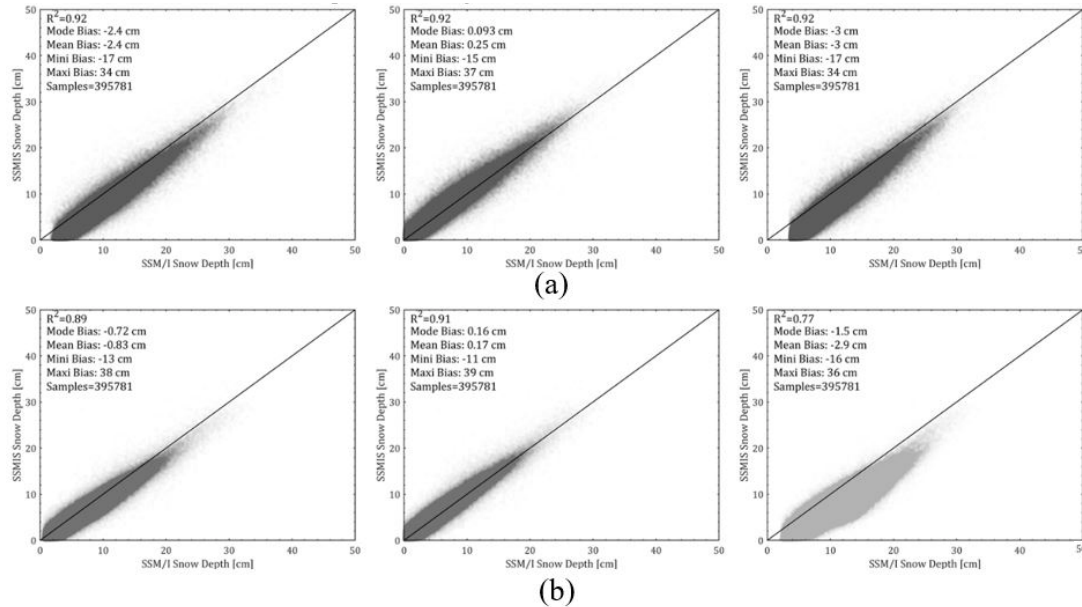
Figure 16. Scatter plots of snow depth estimated with the same algorithm but different satellite observations. ( a ) Dual-channel algorithm; ( b ) multichannel algorithm. The Tbs calibrated with group 1 and group 2 equations were denoted by F13CS (calibrated in snow-covered areas) and F13CA (calibrated in all areas), respectively. Left: F17 vs. F13; middle: F17 vs. F13CS; right: F17 vs. F13CA.